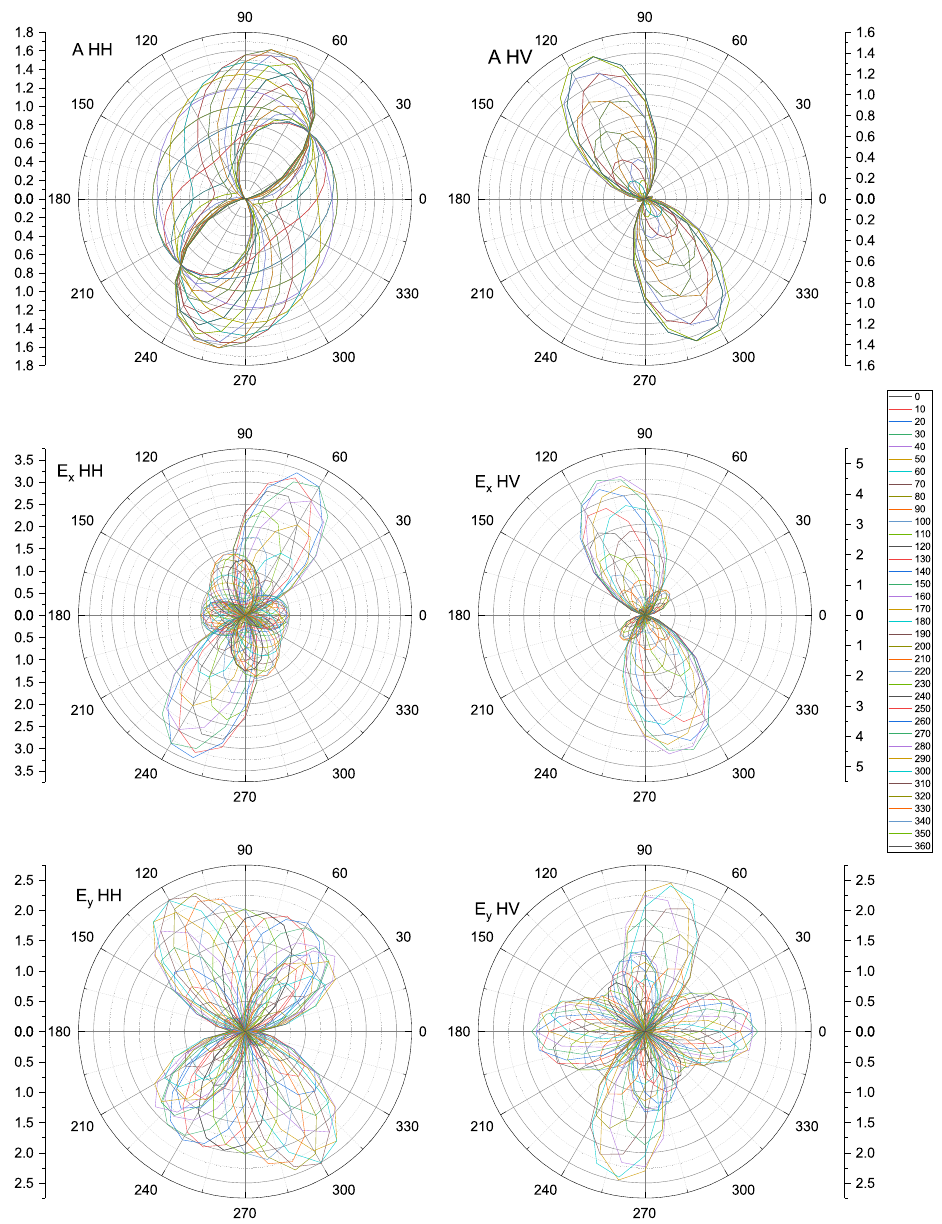
Figure A2. Calculated intensity dependence of Raman modes in the HH and HV polarisation on rotation angle in the plane. The angle to z -axis (vertical) is 60